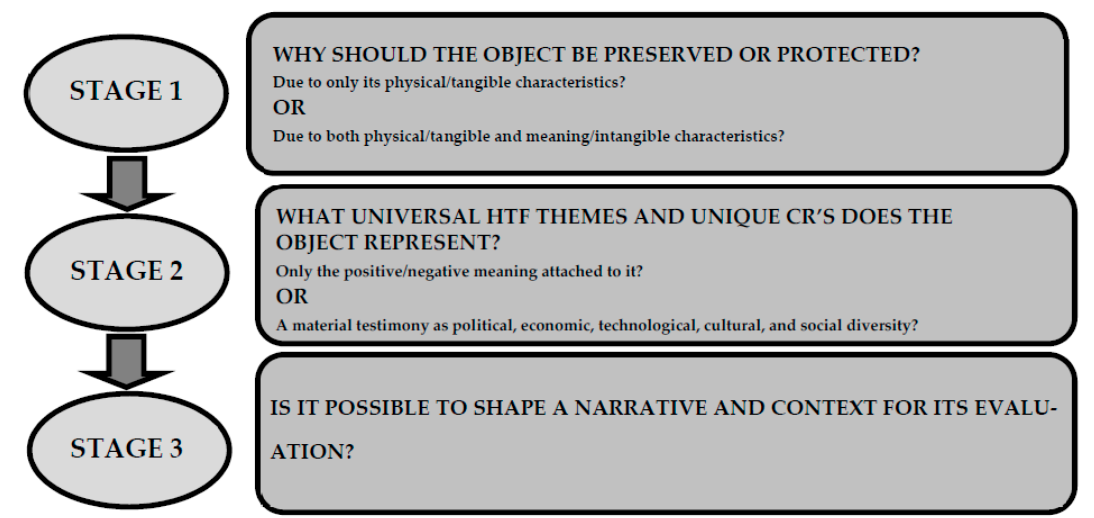
Figure 1. Overview of the identification of developing objective criteria for heritage assessment by cultural